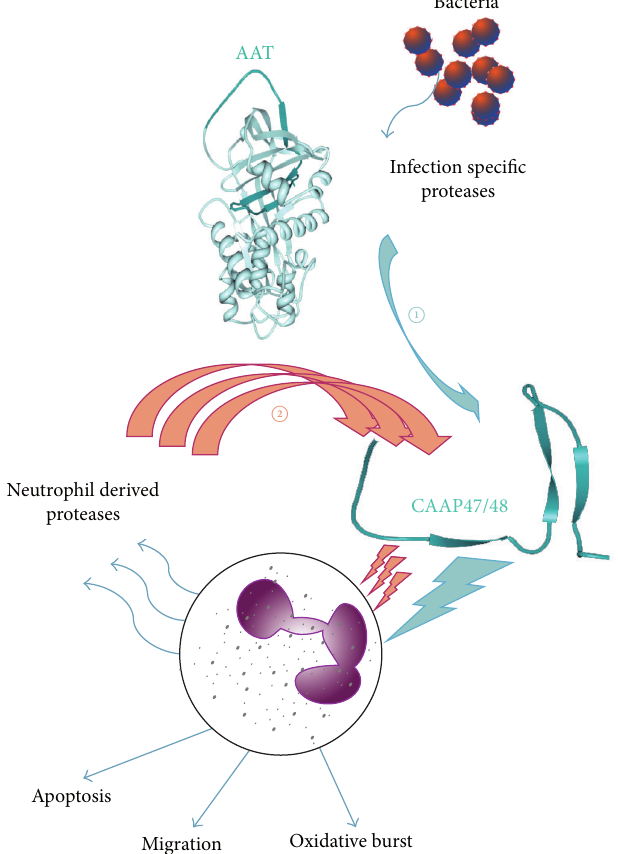
Figure 9: Hypothetical pathway illustrating CAAP47/48 generation by infection specific proteases. (1) In severe sepsis infection specific proteases are activated that lead to AAT cleavage and thus generation of CAAP47/48 (blue arrows). This proteolytic fragment activates PMN, which in turn leads to secretion of further proteases from PMN that will result in additional cleavage of ATT and accumulation of CAAP47/48 (2), that subsequently activates other PMN (red arrows). Due to the activation of further PMN and the induction of migration, cell death, and oxidative burst, this activation loop contributes to a strong enhancement of